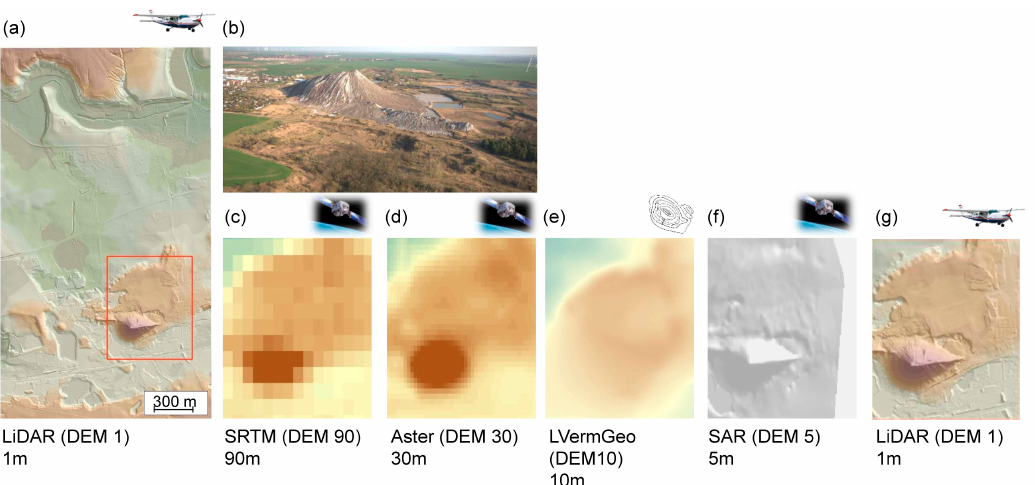
Figure 8. For discrimination and thus for successful monitoring, in addition to the characteristics and the distribution of geomorphic traits and their changes, it is also the spatial characteristics of the RS sensors used that are of major importance–in this case the spatial resolution. DEM comparison of a post-mining potash tailings pile, Teutschenthal-Bahnhof, near Halle, Germany (see also Schwefel et al.,